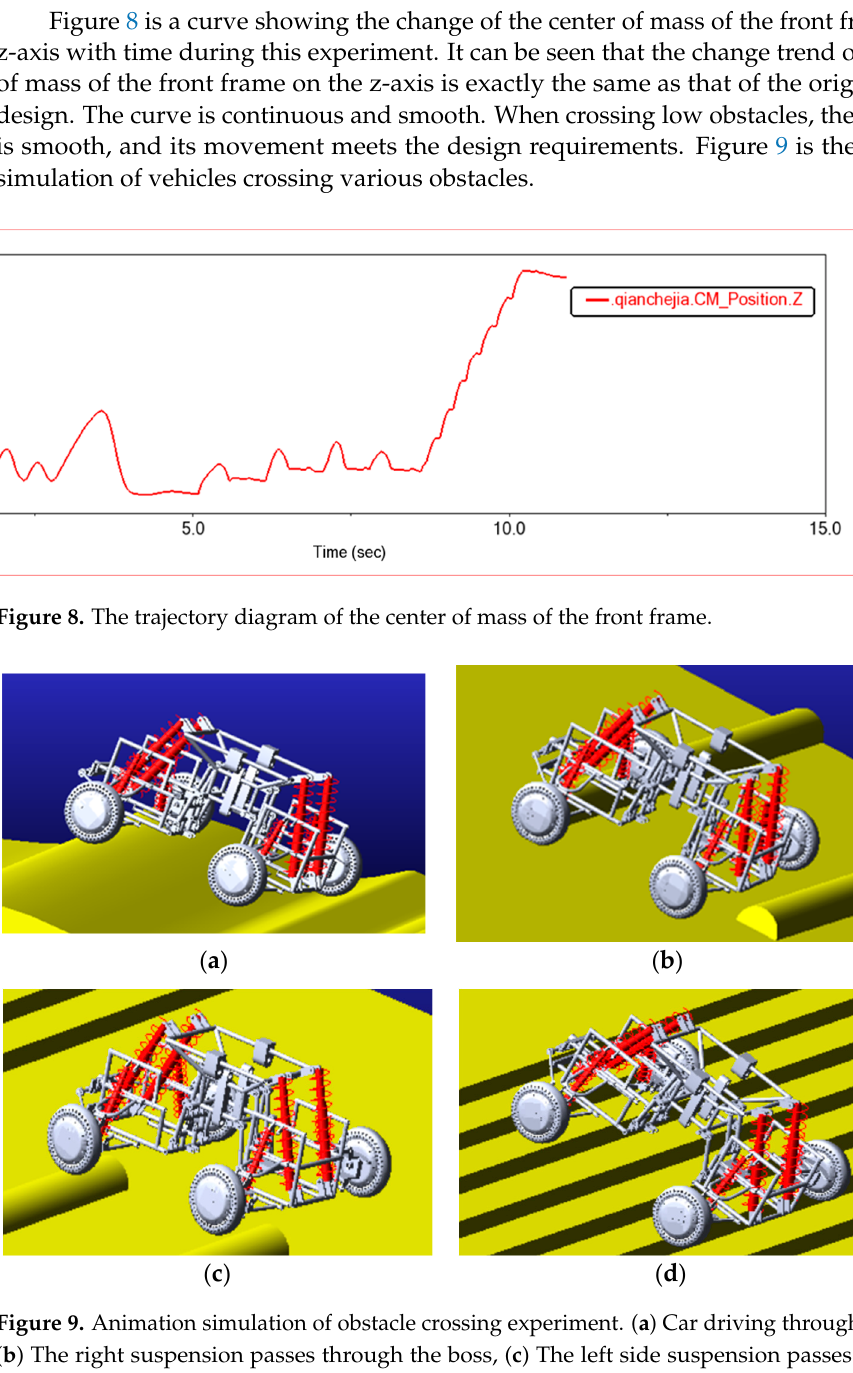
Figure 7. The first section of the experimental terrain.